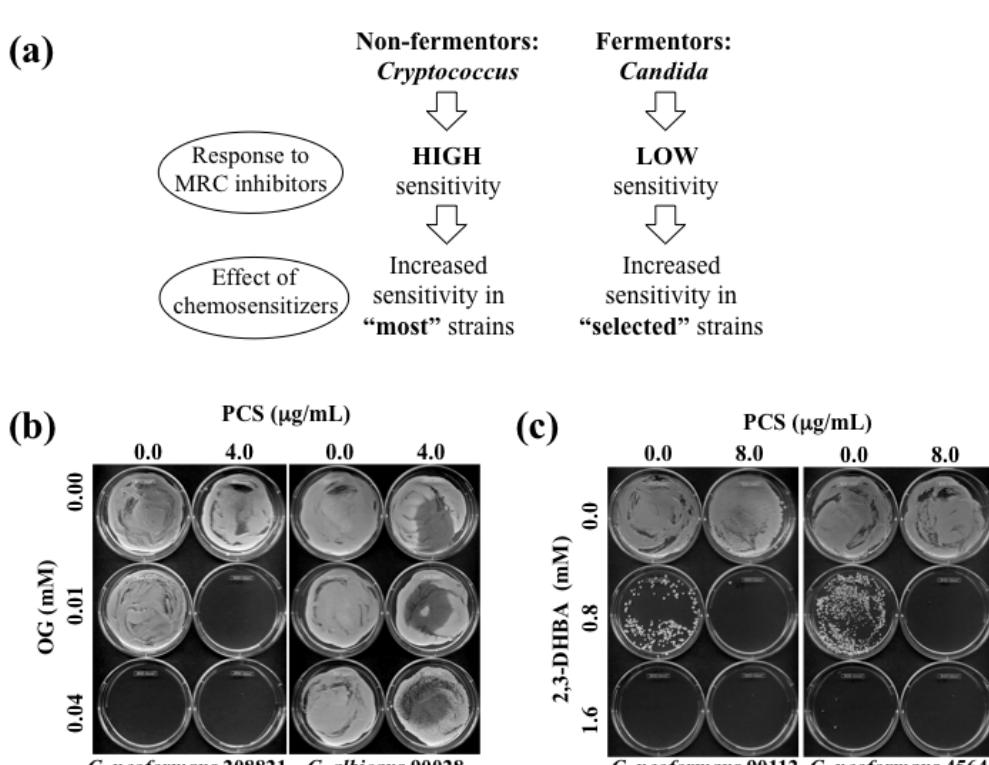
Figure 3. (a) Diagram describing effects of OG- or 2,3-DHBA-mediated chemosensitization to PCS in “most” Cryptococcus strains (non-fermentors) or in “selected (e.g., five sensitive strains described in Tables 6 and 8)” Candida strains (fermentors). (b) Representative MFC test results performed in C. neoformans 208821 and C. albicans 90028 after chemosensitization (PCS + OG). Results showed that C. neoformans 208821 (non-fermentor) was more sensitive ( i.e. , “no growth” with PCS chemosensitization than C. albicans 90028 (fermentor) ( i.e. , “growth” with PCS OG ). (c) Representative MFC test results performed in C. neoformans 90112 and 0.01 mM 4564 after chemosensitization (PCS +